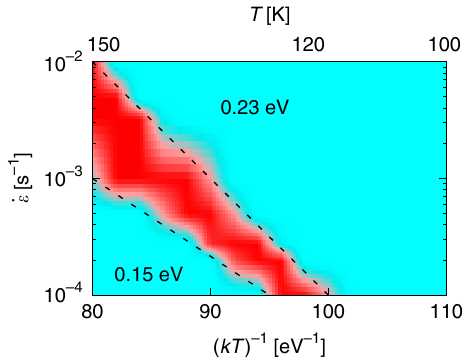
Fig. 6 Using simulation results to map to engineering design curves. Color map of the strain rate-inverse temperature diagram obtained from our simulations. Each pixel in the fi gure is colored according to the propensity for jerky fl ow de fi ned in the text, with red and cyan indicating high and low propensities, respectively. The dashed lines correspond to two (cid:4) (cid:5) different fi ts of the general equation _ ε T ð Þ ¼ _ ε 0 exp (cid:2) Δ E kT , with the values of Δ E given next to